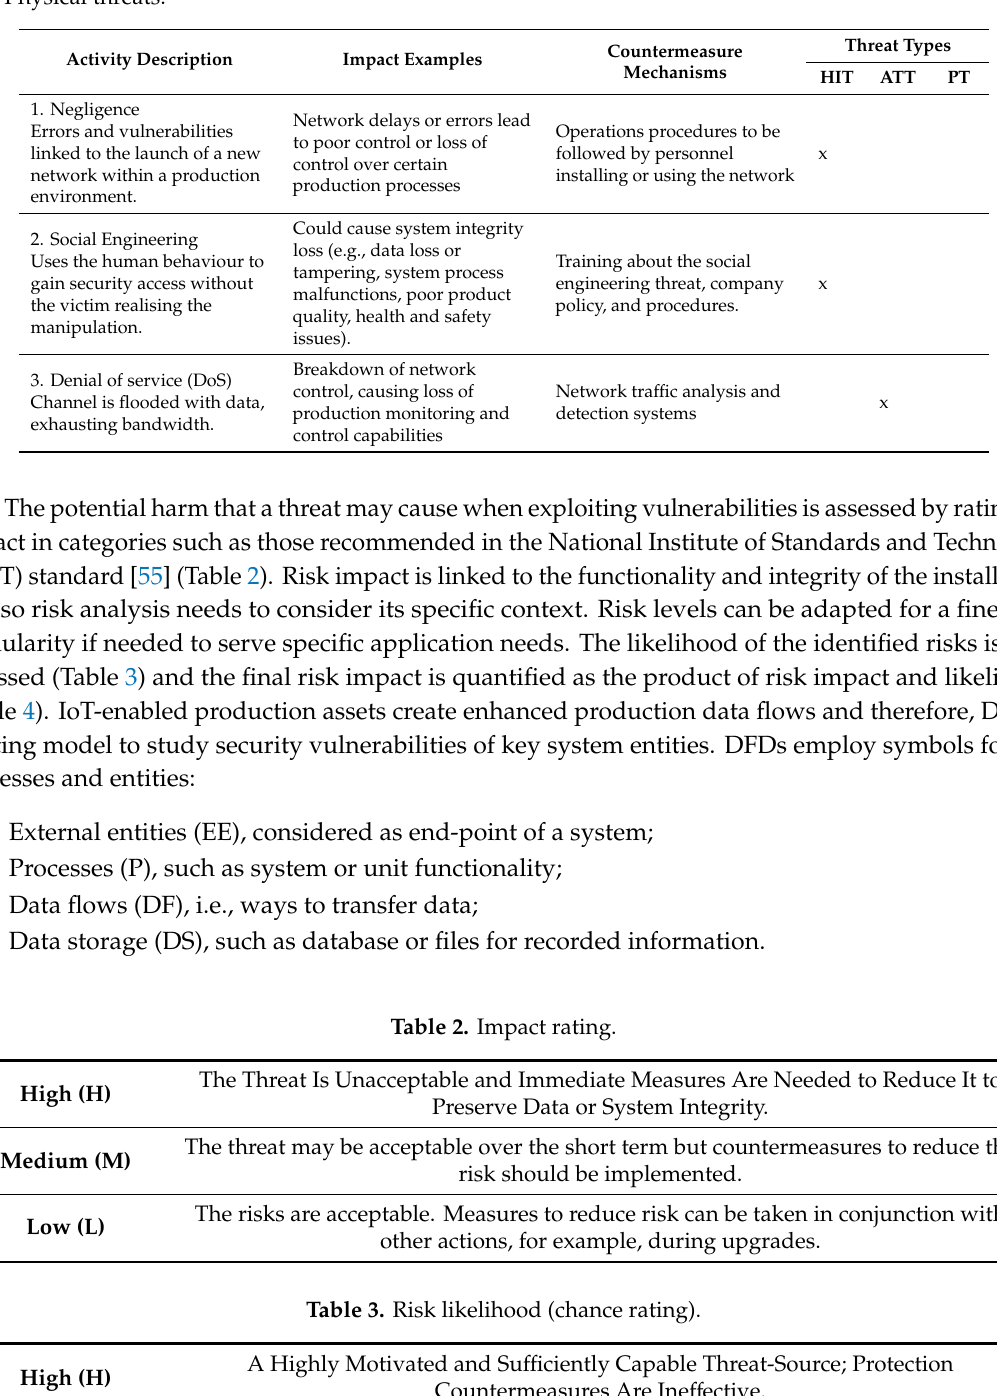
Table 1. An example of threat analysis. HIT: Human interaction; ATT: Advanced technical; PT: Physical threats.